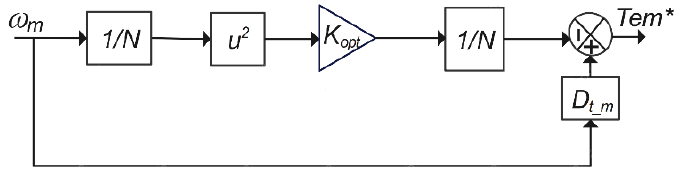
Figure 7. MPPT controller applied to the rotor-side converter.